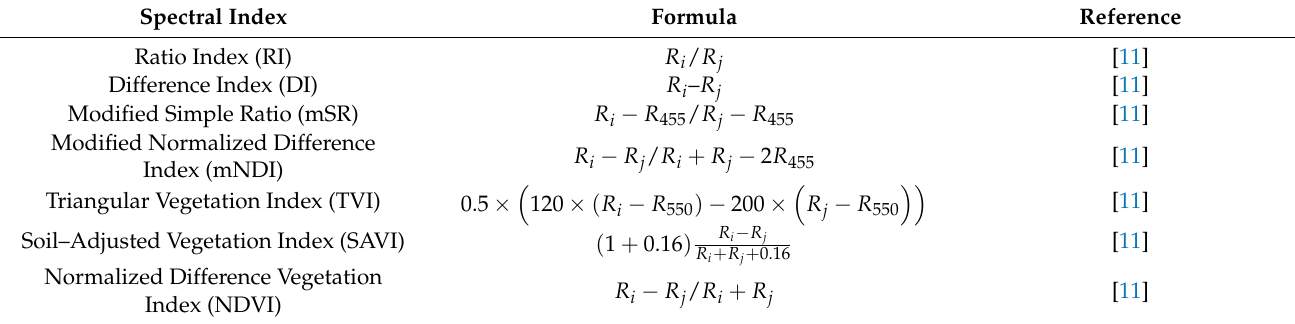
Table 2. The spectral index selected in this